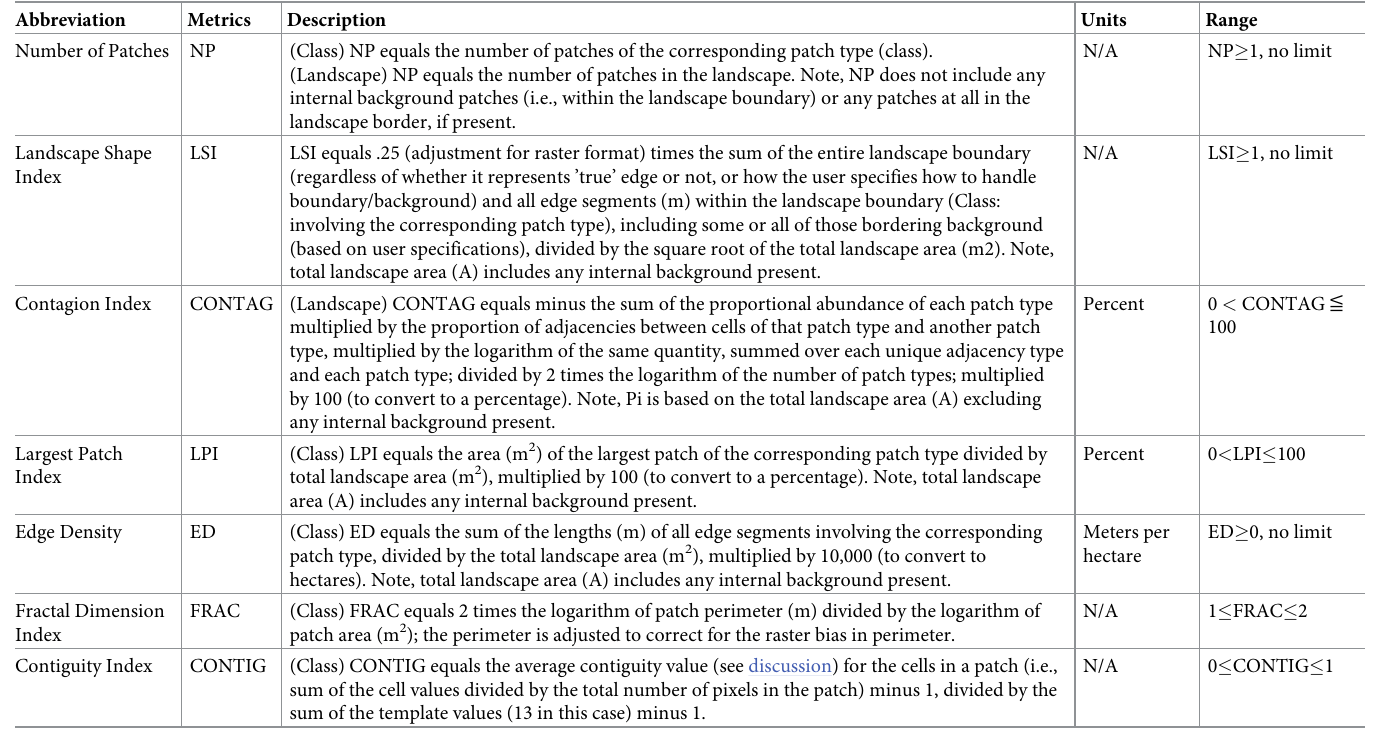
Table 3. Description of landscape metrics used in this